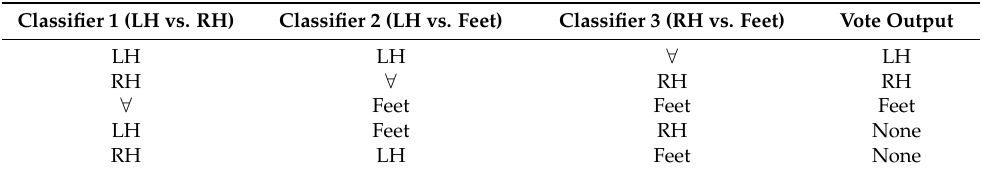
Table 1. Voting method for three MI states.